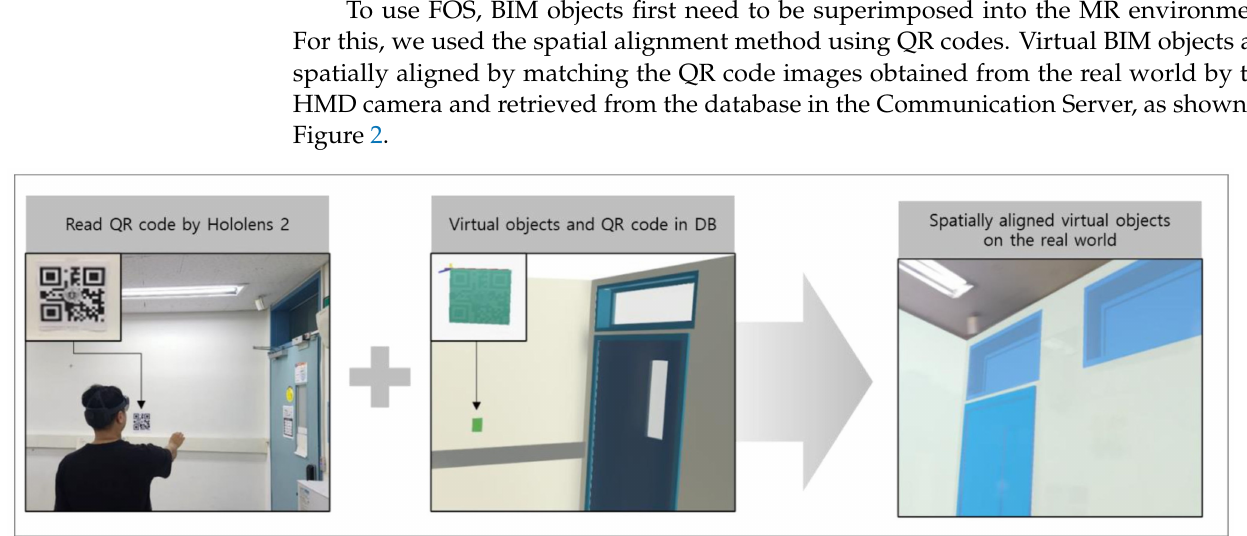
Figure 2. Spatial alignment process using QR